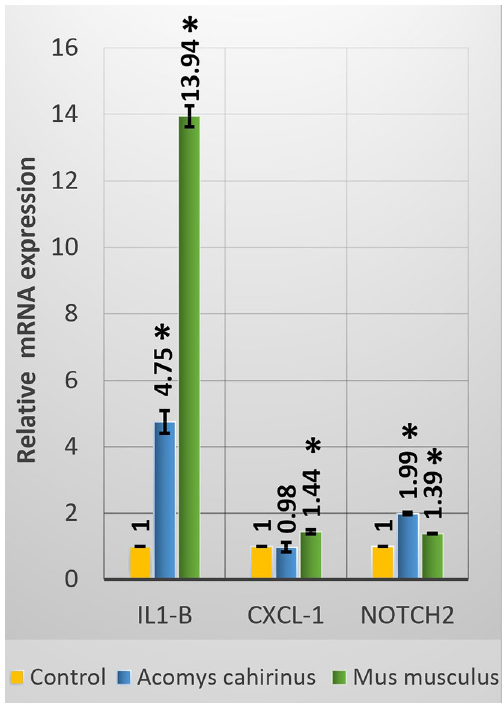
Figure 5. Gene expression analysis of IL1-β , CXCL-1 , and Notch 2 in brain samples of Acomys cahirinus and Mus musculus following subacute administration of LA relative to the corresponding controls standardized to one. Data presented as mean ± standard error of mean. Asterisk: significant difference where p <